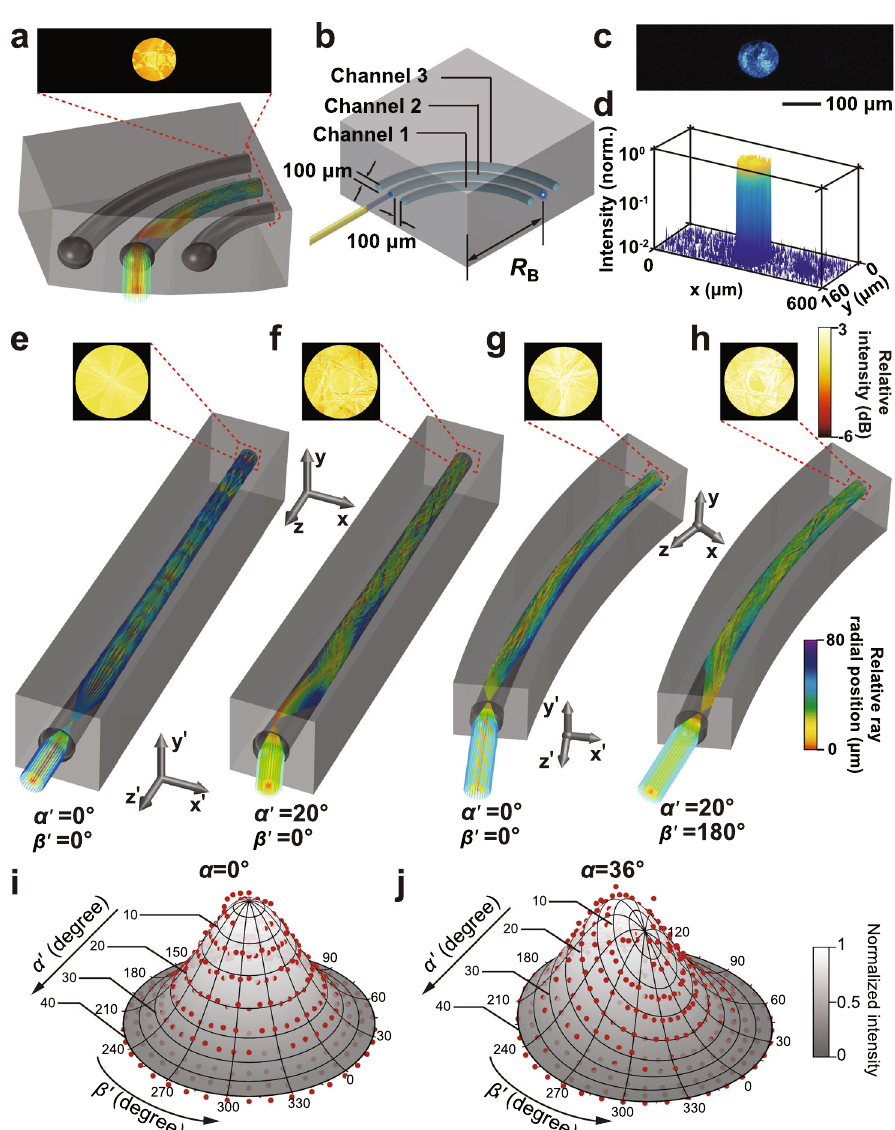
Fig. 3 Optical performance of the arti fi cial ommatidia. a Simulation of optical crosstalk among the three ommatidia with orientations of ( α = 64.8° , β = 0°), ( α = 72° , β = 0°), and ( α = 79.2° , β = 0°) and intensity distributions at the proximal ends of the waveguides when the light is incident on the middle ommatidium. b A three-channel model to measure the crosstalk among the curved silicone waveguides. c Image captured at the output panel showing the light intensity at the proximal ends of the three silicone waveguides. d The measured light distribution at the output panel. e – h Simulation of ray tracing in the ommatidia with orientations of ( e , f ) ( α = 0° , β = 0°) and ( g , h ) ( α = 36° , β = 0°) and light intensity distributions at the proximal ends of the waveguides when the light is incident from different angles. i , j The angular sensitivity function of the ommatidia with orientations of ( α = 0° , β = 0°) and ( α = 36° , β = 0°), respectively. Red dots: the normalized intensity obtained from experimental measurements. Grey surface: Gaussian- fi tting